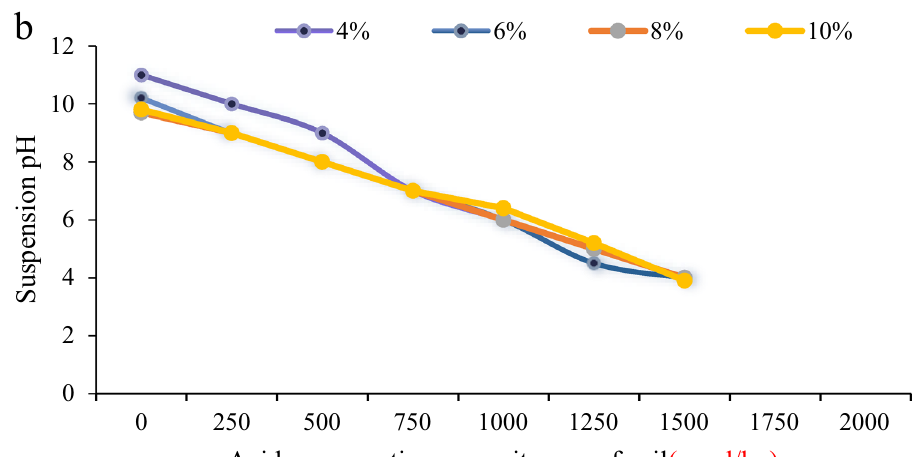
Figure 10. Acid titration curves of soil samples with different contents of curing agent or different curing periods; ( a ) Acid titration curve with curing time of 28 days; ( b ) Acid titration curve with 8% curing